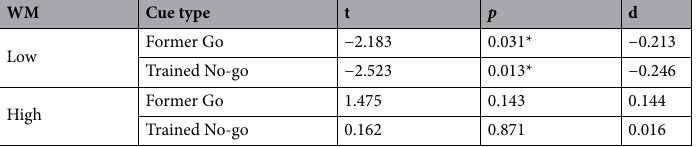
Table 1. One sample t-tests (H 0 = 0) of log-normalised MEP (Fig. 3b). Data were pooled from Experiments 1 and 2 for cue type × working memory load. * p <